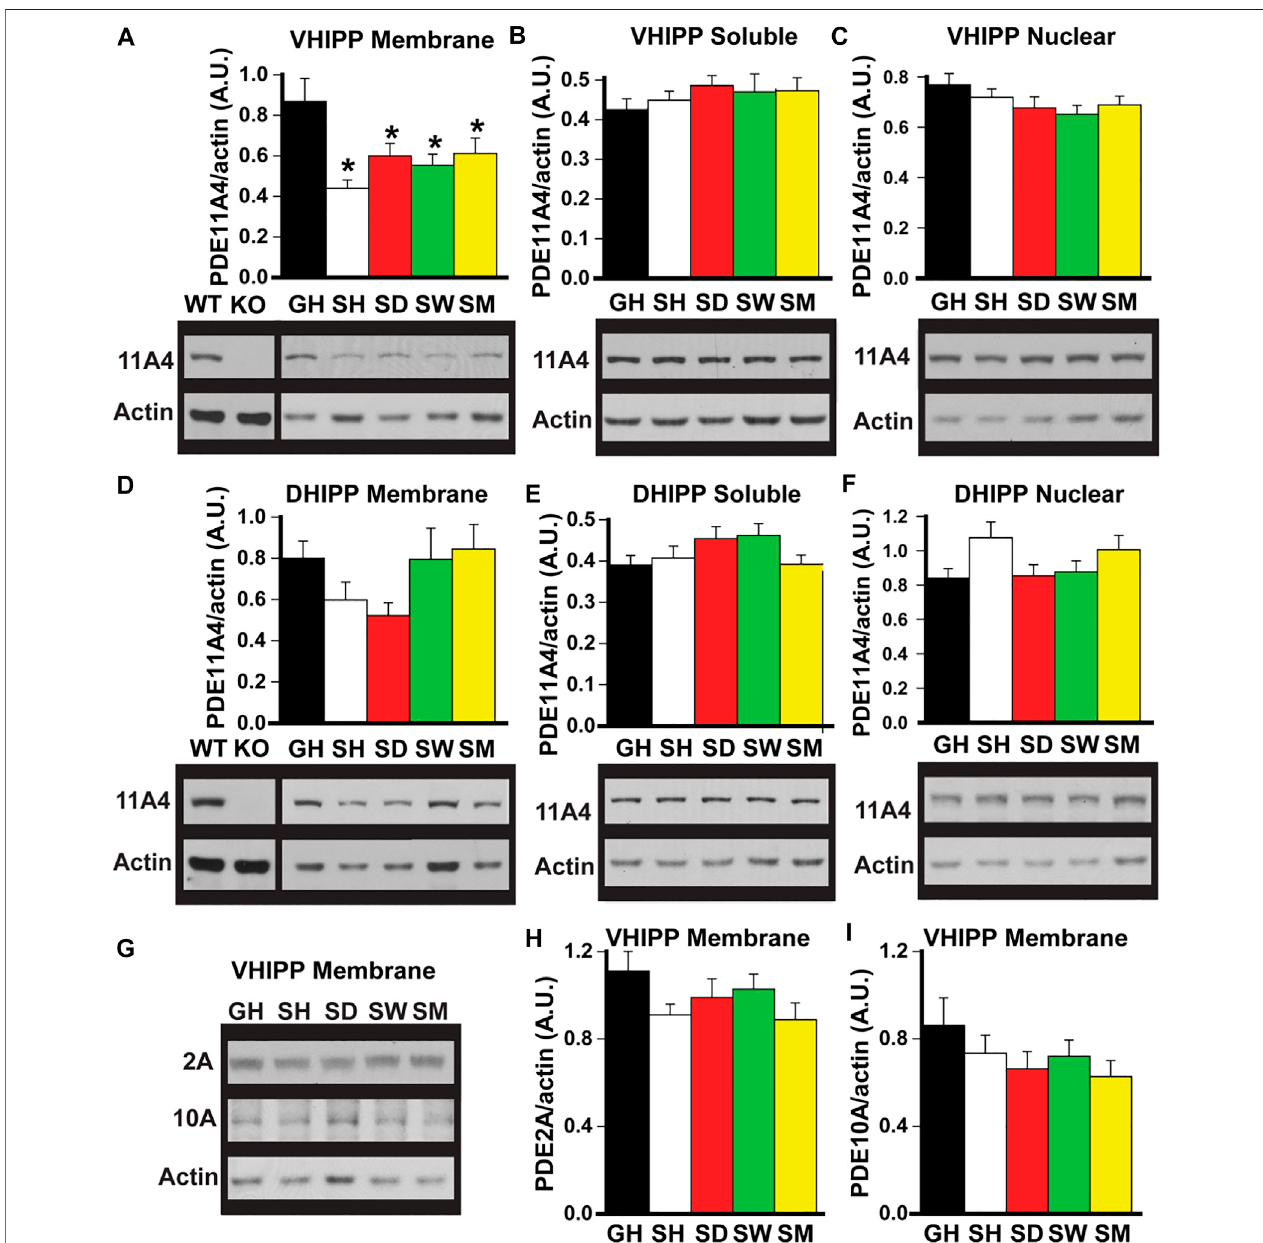
FIGURE1| Socialisolationselectivelydecreases PDE11A4proteinexpression inventralhippocampalmembranefractionsofadultmice.Westernblotswereused to measure PDE protein expression in fractionated samples from hippocampi of adult group-housed mice (GH) and adult mice that were single-housed for 1 h (SH), 1 day (SD), 1 week (SW) or 1 month (SM). Samples from the hippocampi of a Pde11a wildtype (WT) and knockout (KO) mouse are included as a positive and negative control,respectively,forthePDE11A4antibody.CerebellumisrunasanegativecontrolonPDE2Ablots(notshown — see SupplementaryData1 )andstriatumis run as a positive control on PDE10A blots (not shown — see Supplementary Data 1 ). (A) Both acute and chronic isolation decreases PDE11A4 ( ∼ 97kD) protein expression in the VHIPP membrane fraction (n (cid:2) 9 – 10 samples/time point/sex; effectof group: F (4,65) (cid:2) 5.95, p < 0.001; Post hoc: each group vs GH, P (cid:2) 0.007 to p < 0.001), (B) but not the VHIPP soluble fraction (effect of group: F (4,66) (cid:2) 0.991, P (cid:2) 0.42) (C) nor the VHIPP nuclear fraction (effect of group: F (4,66) (cid:2) 1.50, P (cid:2) 0.21). Relative to group housing, social isolation does not signi fi cantly change PDE11A4 expression in the dorsal hippocampal (DHIPP) membrane fraction. A 2-way RM ANOVAforallgroupsfailsequalvariance;however,separateanalysesforGHvsSH,SD,andSMaswellasGHvsSWeachpassnormalityandequalvariance(GHvsSH, SD, and SM effect of group: F (3,51) (cid:2) 4.76, FDR-P (cid:2) 0.011 with Post hoc for each group vs GH, P (cid:2) 0.057-0.868; GH vs SW effect of group: F (1,34) (cid:2) 0.36, FDR-P (cid:2) 0.552),solublefraction (effect ofgroup: F (4,64) (cid:2) 1.74, P (cid:2) 0.152),or nuclear fraction (effect ofgroup: F (4,69) (cid:2) 2.85, P (cid:2) 0.03 with Post hoc for each group vs GH, P (cid:2) 0.057-0.866). (G) To determine whether the isolation-induced decreases in VHIPP membrane PDE11A4 are speci fi c to this PDE family, protein expression of both PDE2A ( ∼ 98 kDA) and PDE10A ( ∼ 80 kDa) were measured in VHIPP membrane samples. Neither (H) PDE2A (effect of group: F (4,65) (cid:2) 1.64, P (cid:2) 0.18) nor (I) PDE10A (effectofgroup:F(4,67) (cid:2) 1.54,P (cid:2) 0.20)differedinexpressionamongthegroups. Posthoc* vsGH,P (cid:2) 0.007to < 0.001.Dataareplottedasmeans ± SEMs.Brightness and contrast of blot images adjusted for graphical